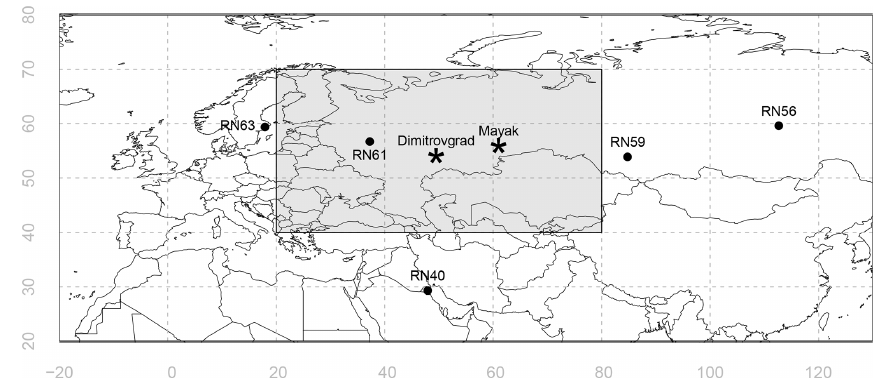
Figure 1. Locations of the five stations from which 106 Ru detections have been used. The shaded box shows the search domain of the Bayesian inference. For reference, the locations of two nuclear facilities are also shown: the Research Institute of Atomic Reactors in Dimitrovgrad, labelled “Dimitrovgrad” (54.19 ◦ N, 49.48 ◦ E) and the Mayak Production Association in Ozyorsk, labelled “Mayak” (55.70 ◦ N, 60.80 ◦ E). Table 1. List of 12 observations with their corresponding sampling times and location. Station Collection start (UTC) Collection stop (UTC)